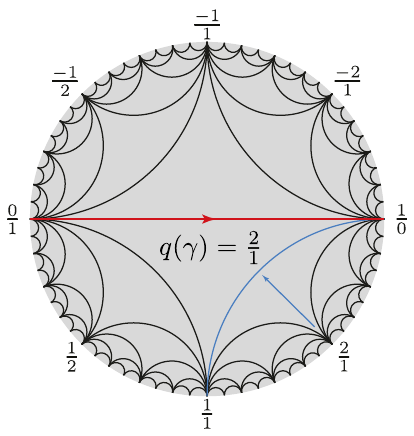
Figure 21 . The labelling of the ideal vertices (endpoints of edges of the tessellation) by rational